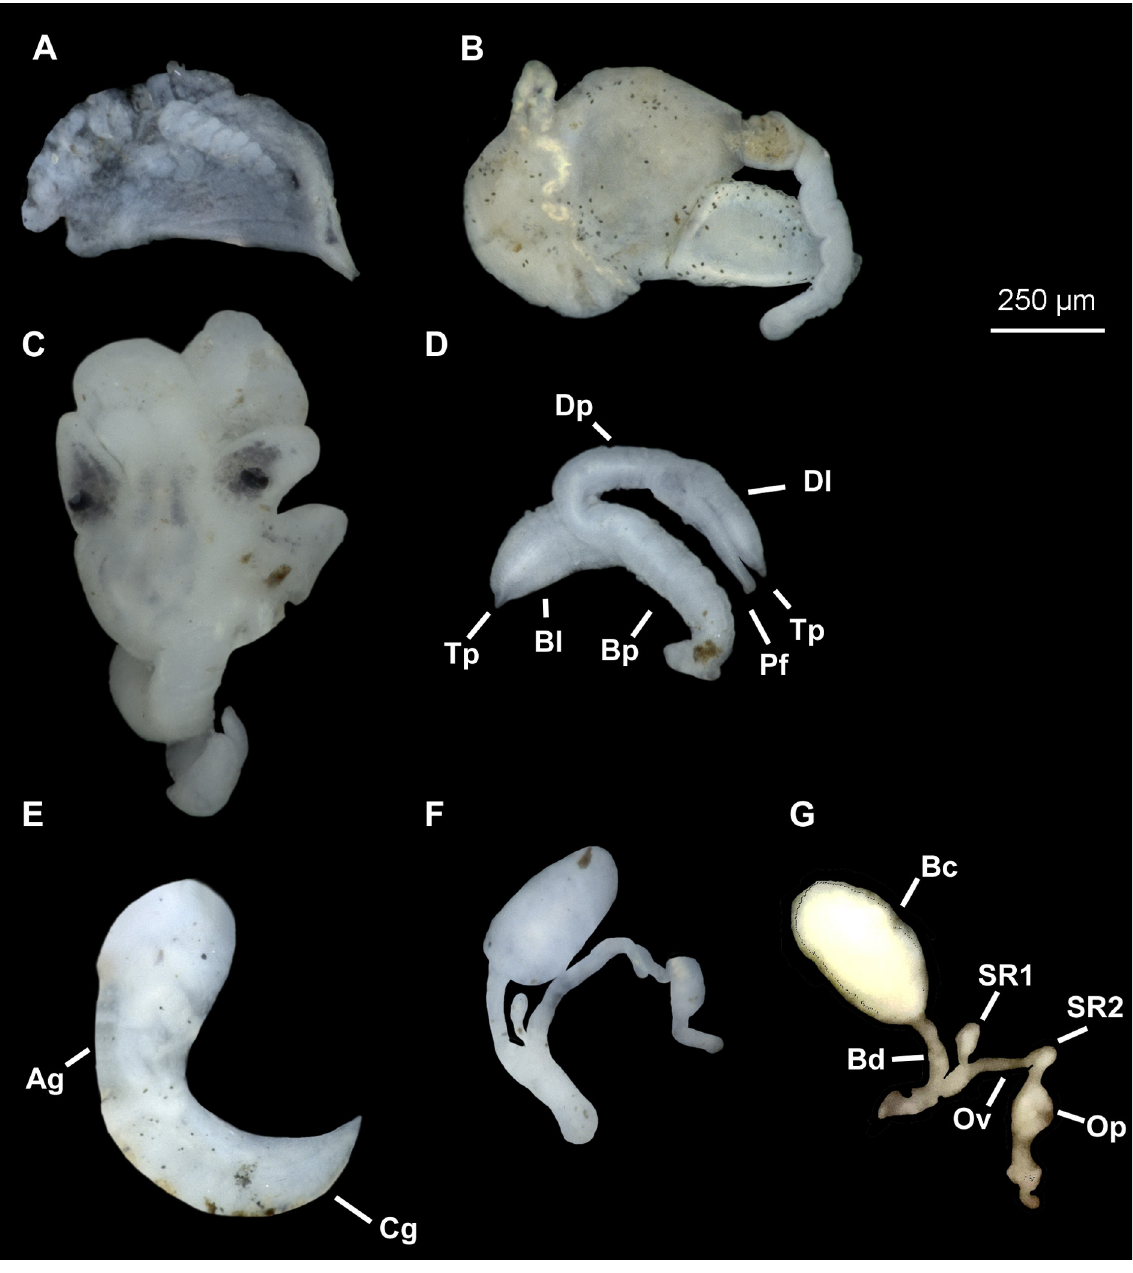
Fig. 6. Anatomy of Belgrandiellopsis secunda gen. et sp. nov. (paratypes, UGSB 17666). A . Ctenidium and osphradium. B . Stomach. C . Head of male and penis. D . Detail of penis and penis lobes. E . Pallial oviduct. F . Bursa copulatrix and seminal receptacles. G . Ditto, observed by transmitted light. Anatomical abbreviations explained in the